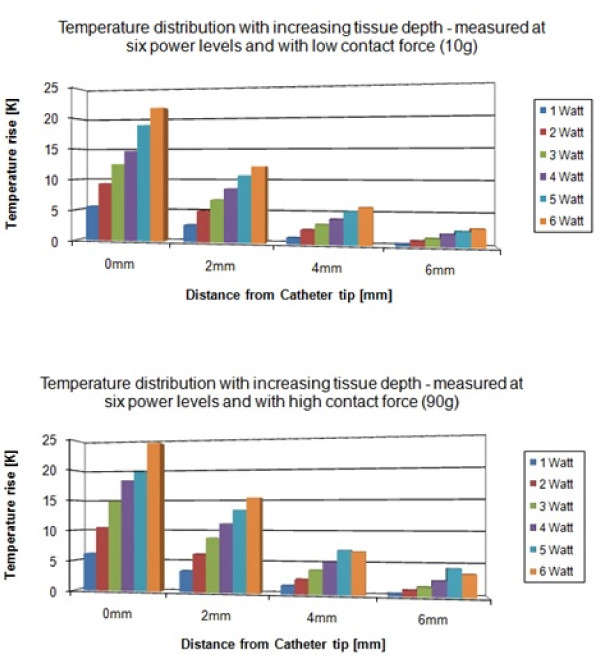
Ablation generator induced temperature rises. Temperature distribution measured at increasing tissue depth from the catheter tip. Different power levels were examined. The upper figure shows the temperature development at a low contact force. The lower figure shows a similar development of temperature that was measured at a high contact force. The distribution of heat is not significantly influenced by the contact pressure. Additionally, the temperature decline due to increasing distance from the catheter tip remains unchanged.